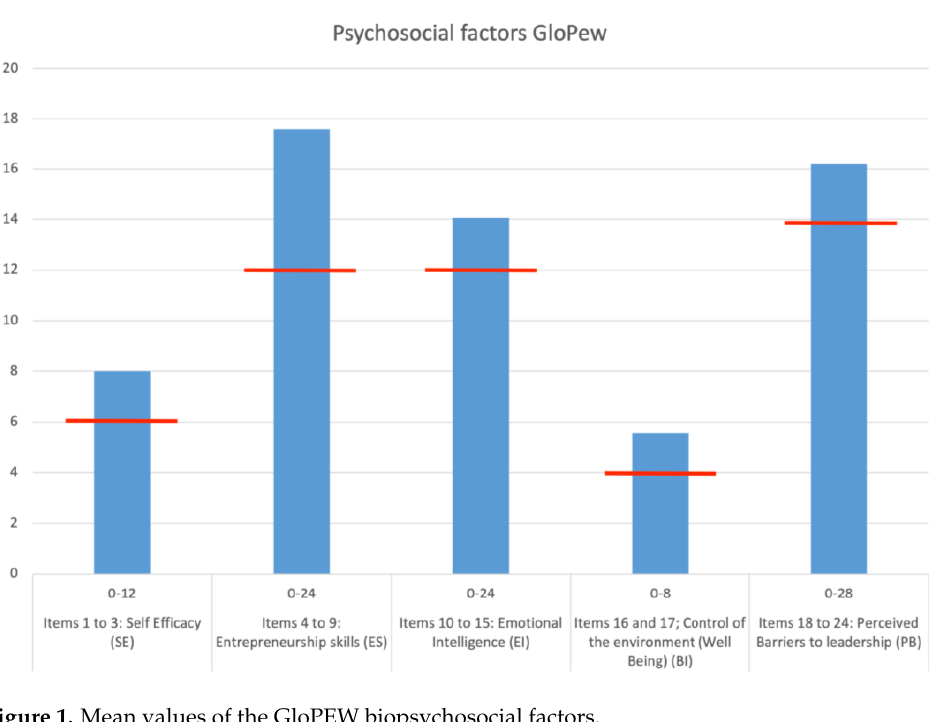
Figure 1. Mean values of the GloPEW biopsychosocial factors.